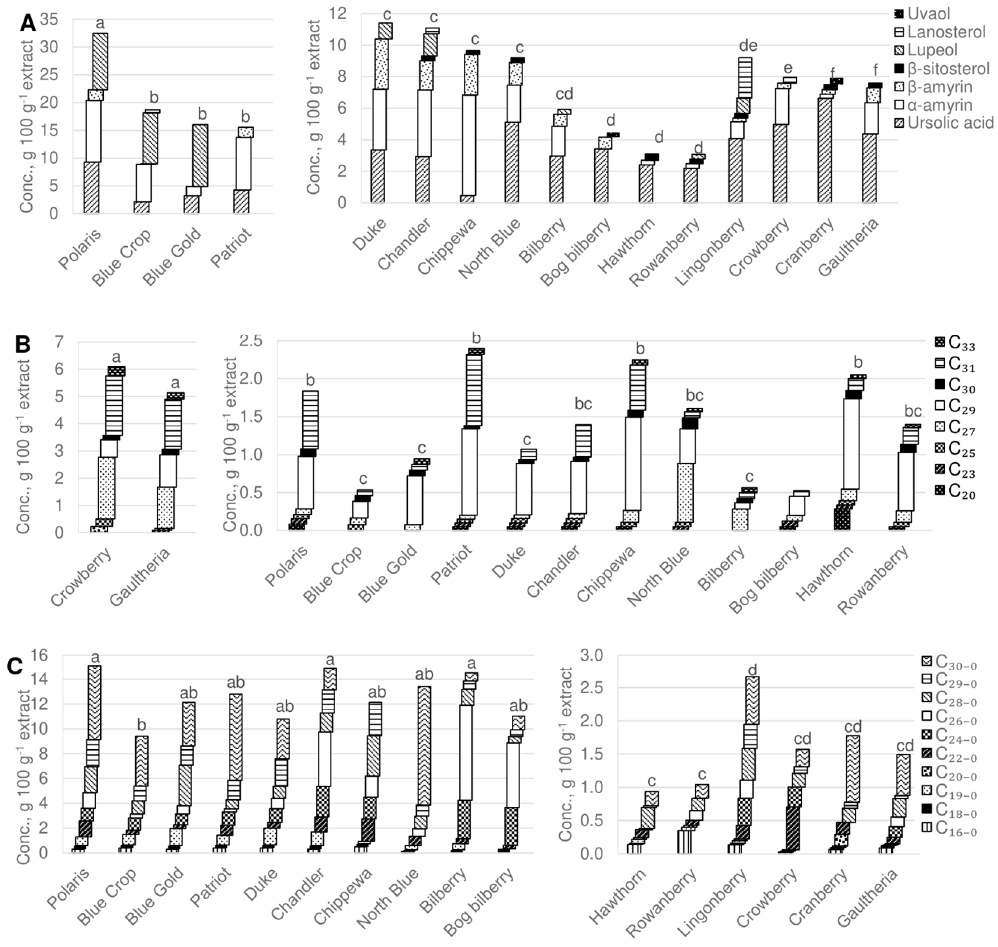
Figure 2. Concentration and composition of sterols ( A ); alkanes ( B ); and fatty acids ( C ) in studied berry waxes. C 16 –C 33 in ( B ) represent the chain length of alkanes (number of C atoms). C 16-0 –C 30-0 in ( C ) represent the length of fatty acids, where − 0 represent the number of double bonds in the fatty acid molecule. Crowberry—black crowberry. Cranberry—American cranberry. Letters above the bars represent significantly different post-hoc pairwise comparison of total concentration of measured substances in respective berry.